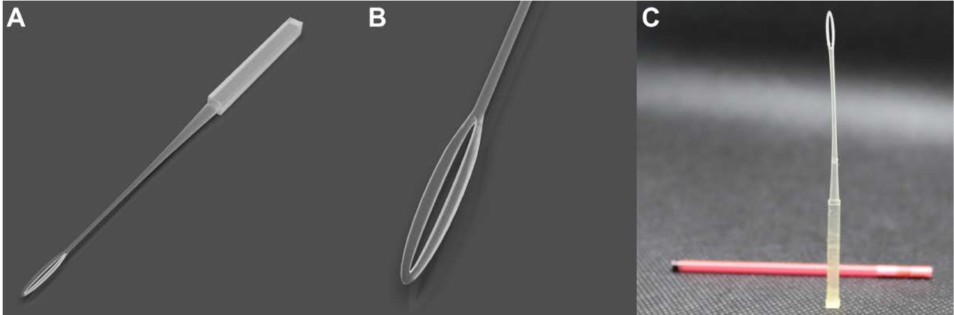
Figure 1. Vitrification device design and 3D-printing prototype. ( A ) Full device rendering. ( B ) Detail of the gamete and embryo deposition area. ( C ) 3D-printed device with a cap to generate a closed